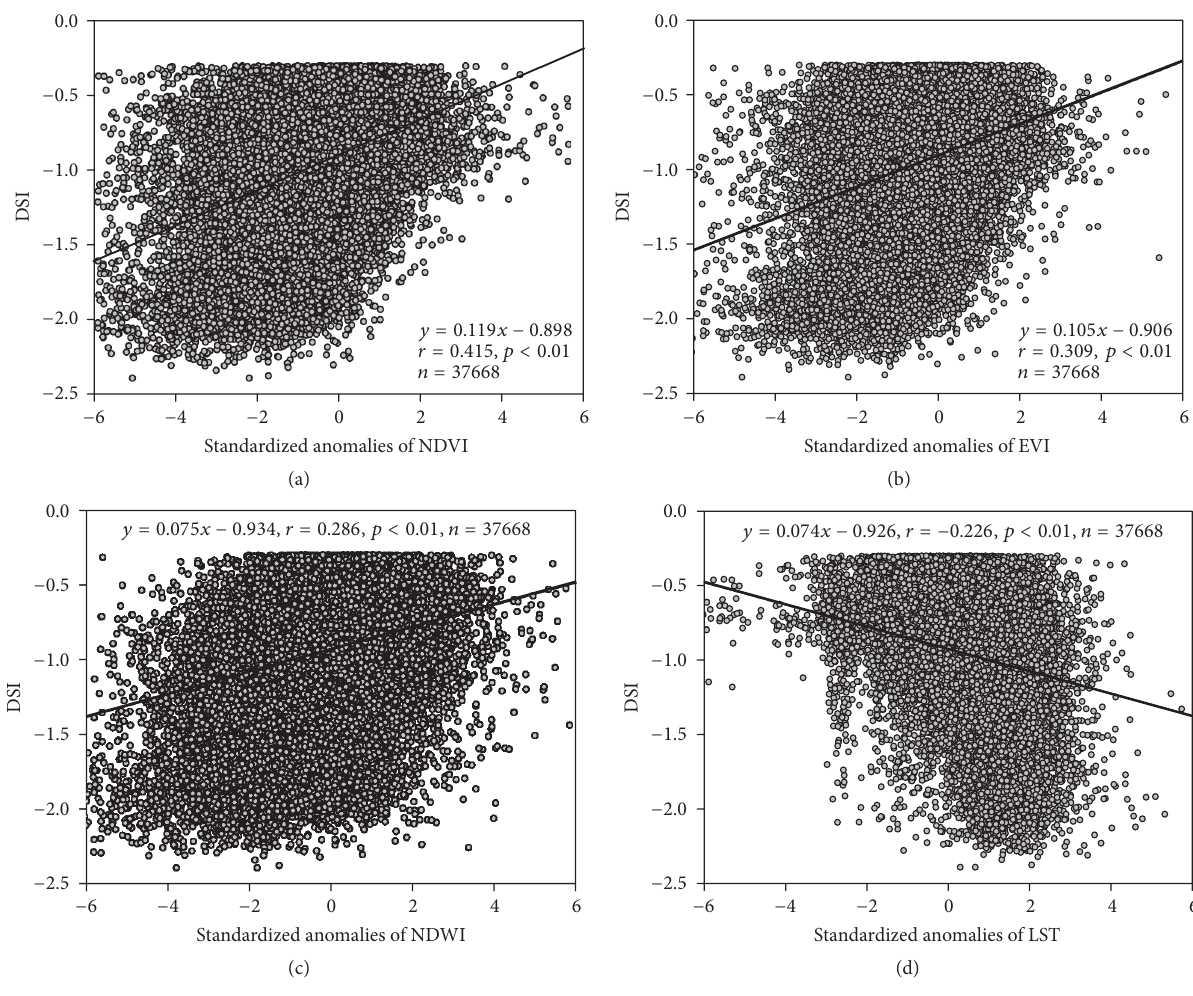
Figure 6: Relationships between DSI and standardized anomalies: (a) for NDVI, (b) for EVI, (c) for NDWI, and (d) for LST during the drought period in vegetated areas, which suffered from the 2009/2010 drought over southwestern